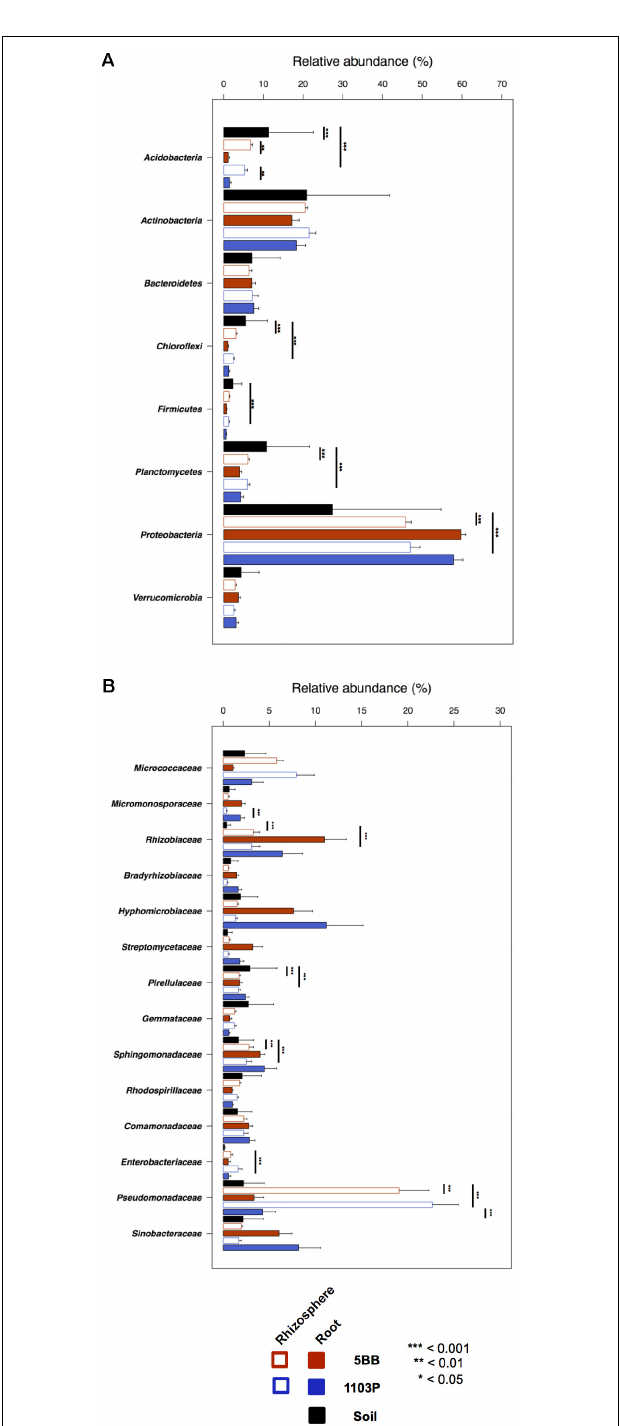
FIGURE 3 | Taxonomic composition of bacterial communities in soil, rhizosphere, and root compartments for V. vinifera cultivar Lambrusco grafted onto different rootstocks. Relative abundance (mean ± SEM) of the most abundant phyla (A) and families (B) in soil, rhizosphere, and root samples for both groups of plants analyzed ( V. vinifera 1103P and V. vinifera 5BB). Stars indicate significant differences [Mann-Whitney-Wilcoxon test, false discovery rate (FDR)-adjustment]. Only taxa with relative abundance > 0.5% in at least 15 samples were